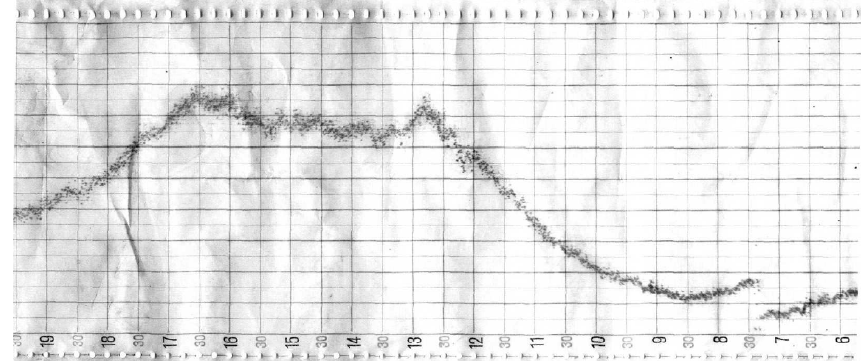
Figure 5. The first record of PG at NCK (Fig. 9 in Bencze,